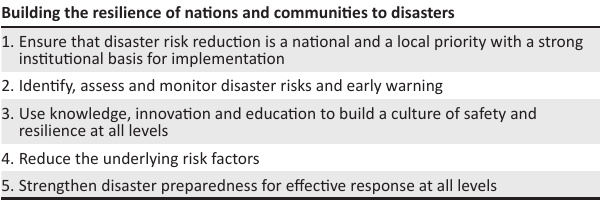
TABLE 1: Hyogo Framework for Action disaster mitigation